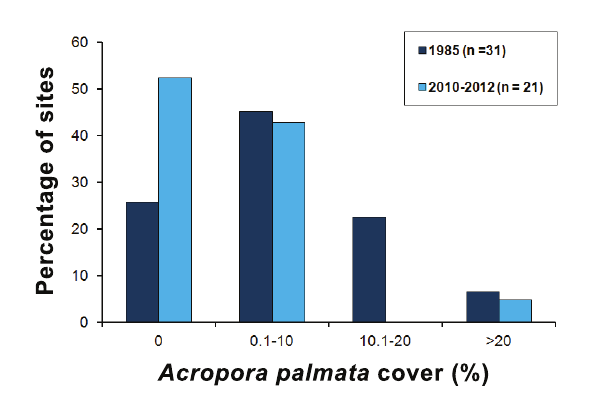
Figure 3. Frequency distributions of mean A. palmata cover recorded in the Mexican portion of the MRS in 1985 (dark blue bars) and in this survey (2010–2012, light blue bars). Data for 1985 are based on the study of Jorda´n-Dahlgren [35,36]; n=number of sites.